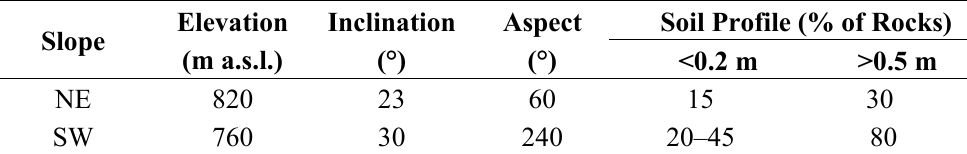
Table 1. Characteristics of the research